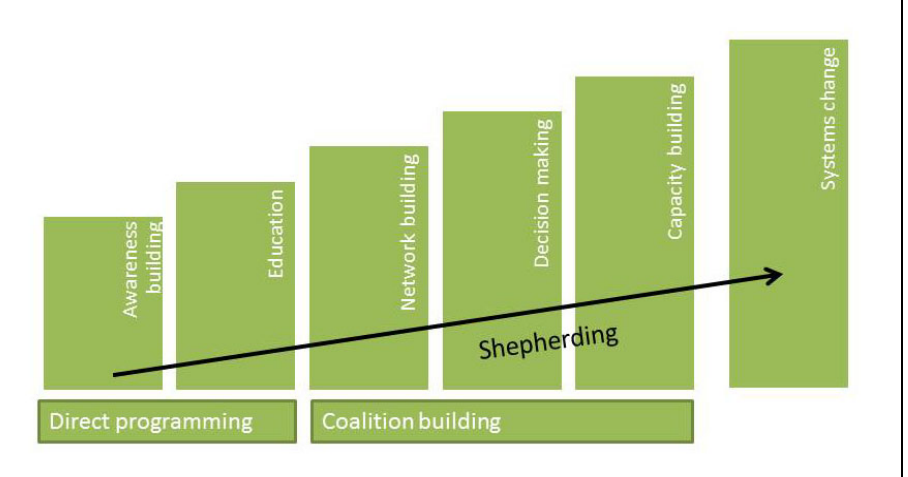
Figure 4. Evolution of Community Engagement for Systems Change Shepherding helps direct programming and coalition building toward systems